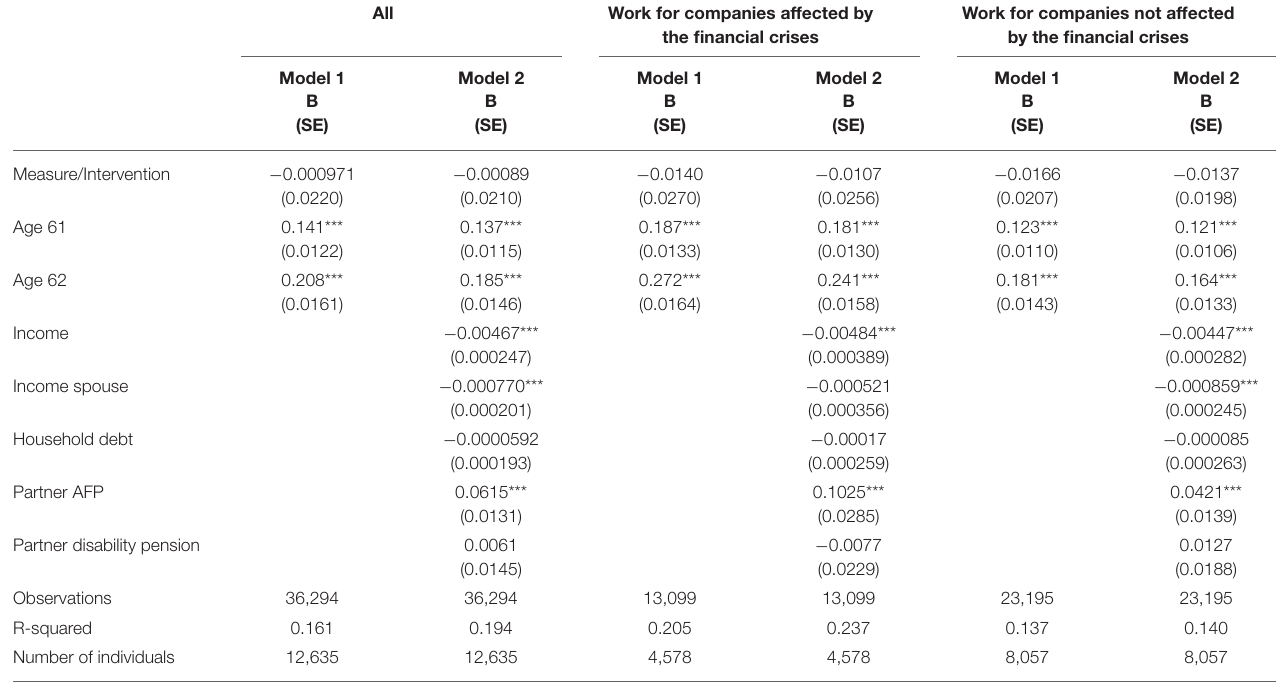
TABLE 2 | Individual probability of receiving an early retirement benefit among 62- and 63-year-olds, depending on the measure exposure (all sort of retention measures), before and after controlling for a range of individual time-variant variables. All Work for companies affected by Work for companies not affected the financial crises by the financial